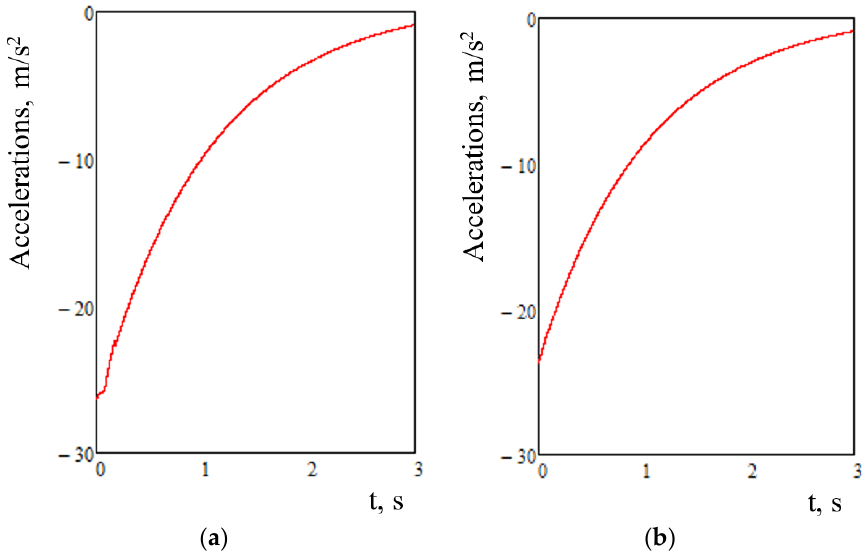
Figure 6. The accelerations to the carrying structure of the flat wagon: ( a ) First section from force application. ( b ) second section from force application.